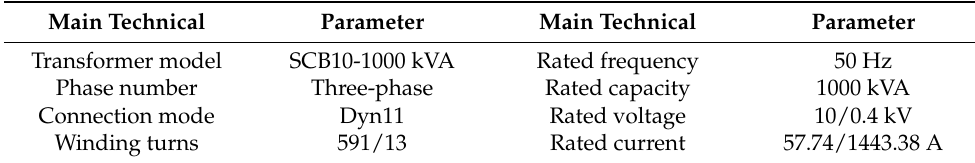
Table 1. Basic parameters of the